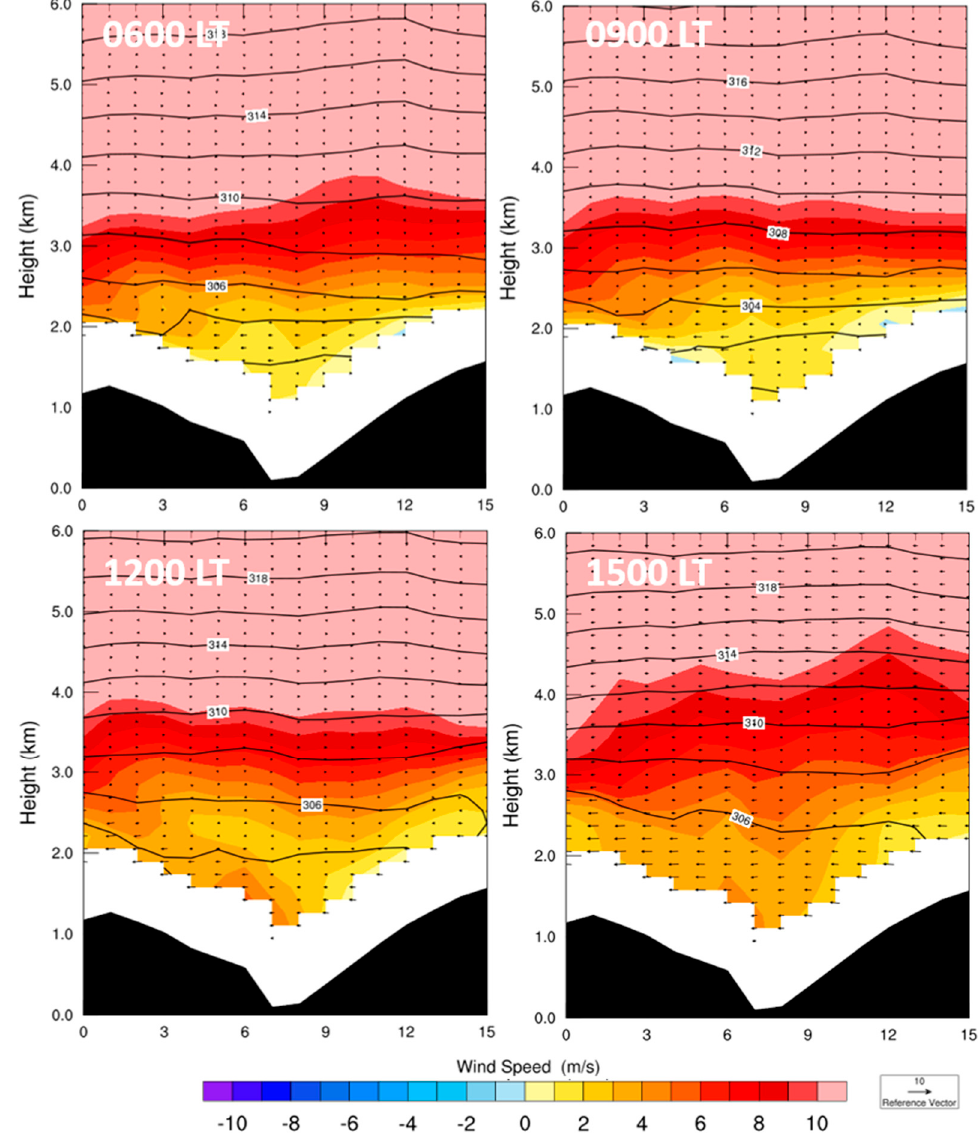
Figure 13. Cross-valley vertical profiles of wind and potential temperature simulated in the 1.33 km domain for non-event day 18 August. Wind vectors indicate wind in the y - z plane. Wind speed is the u-component of the wind; negative values indicate easterly flow. Into the page is west with the north canyon wall on the right. Only the lowest 6 km are shown.